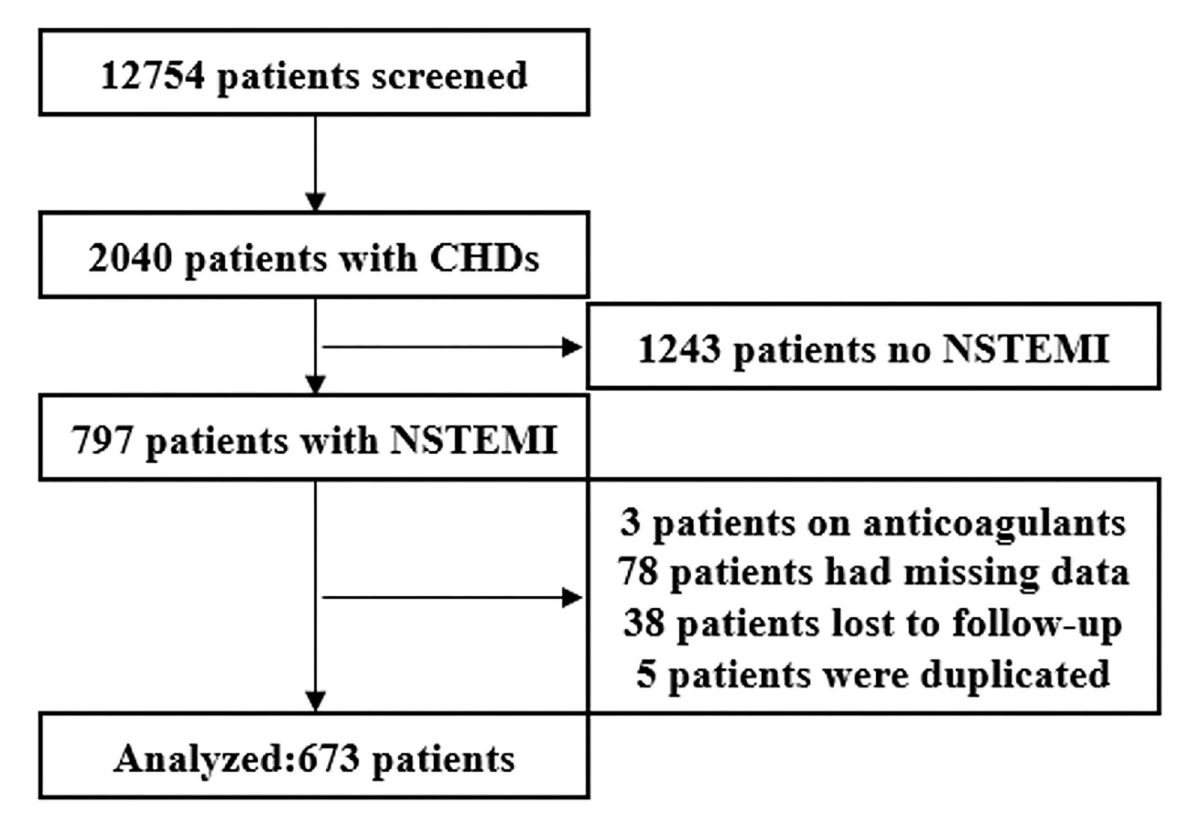
FIGURE1 A flow diagram of the